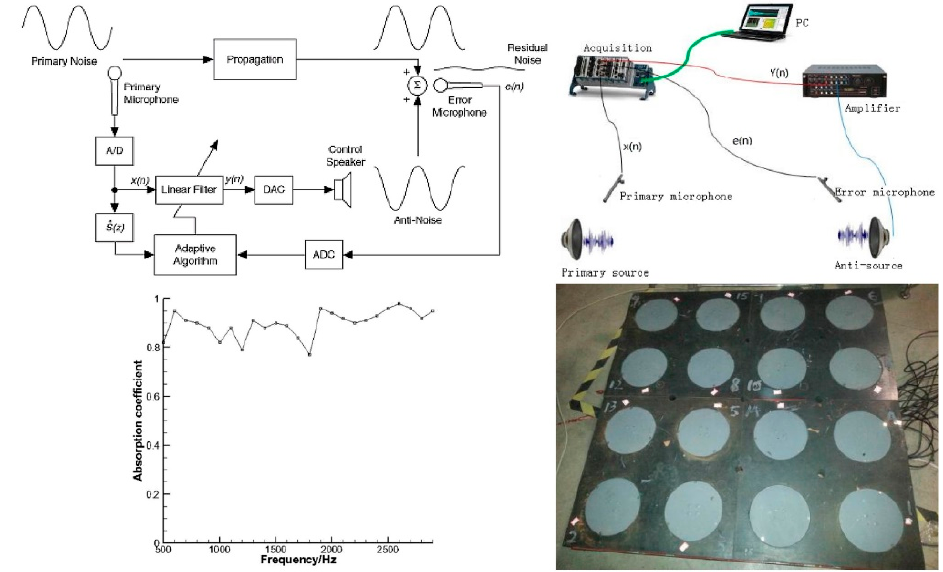
Figure 9. Design on active acoustic coatings. Active control procedure, absorption coefficients at the stable pressure value of 0.96 MPa and an active large plate sample [44].